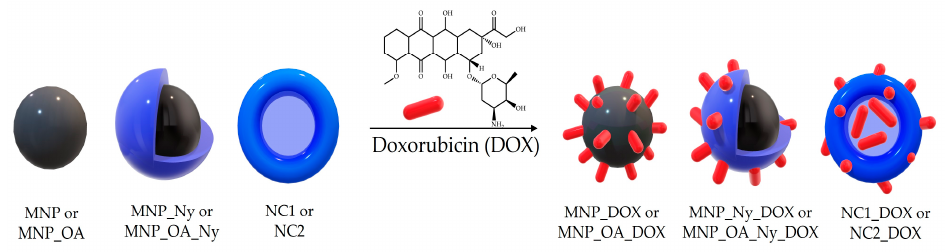
Figure 5. Schematic representation of DOX loading.